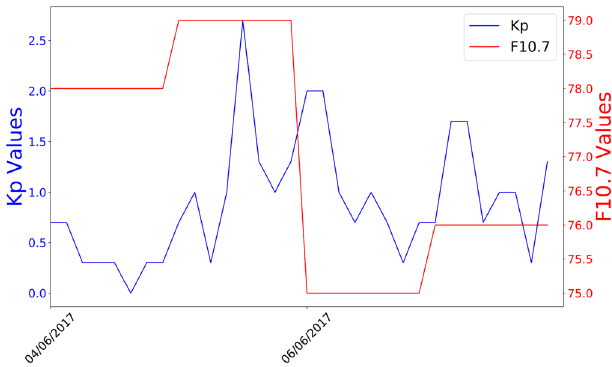
Fig. 2. Kp and F10.7 values for the AENeAS benchmarking